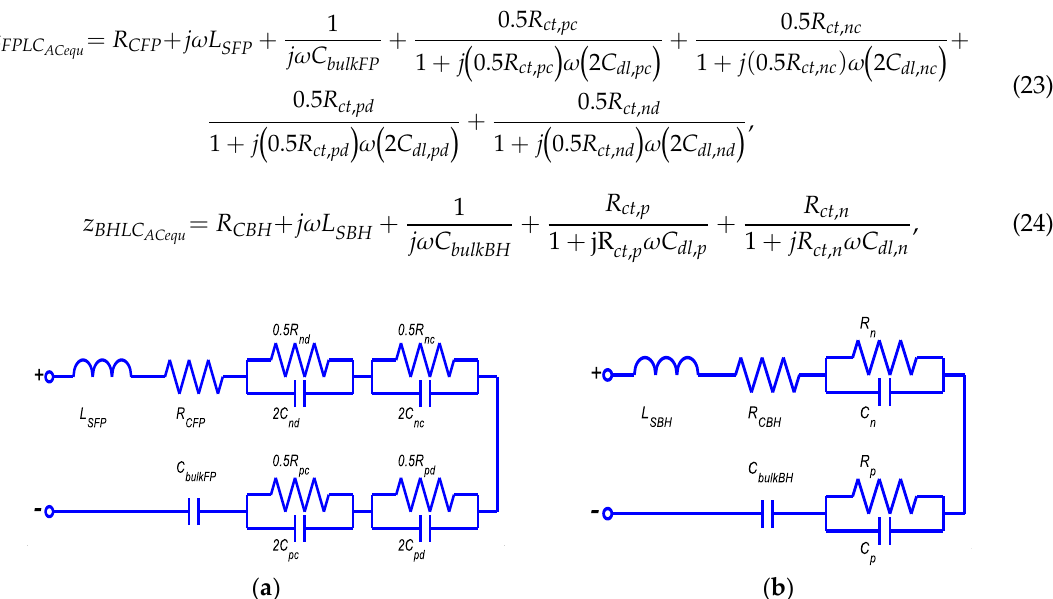
Figure11. CircuitsfittingforEISandBodeplots: ( a ) FPLC ACequ ; ( b )behaviorallinearcircuit( BHLC ACequ ). Figure 11. Circuits fitting for EIS and Bode plots: ( a ) FPLC ACequ ; ( b ) behavioral linear circuit ( BHLC ACequ ).